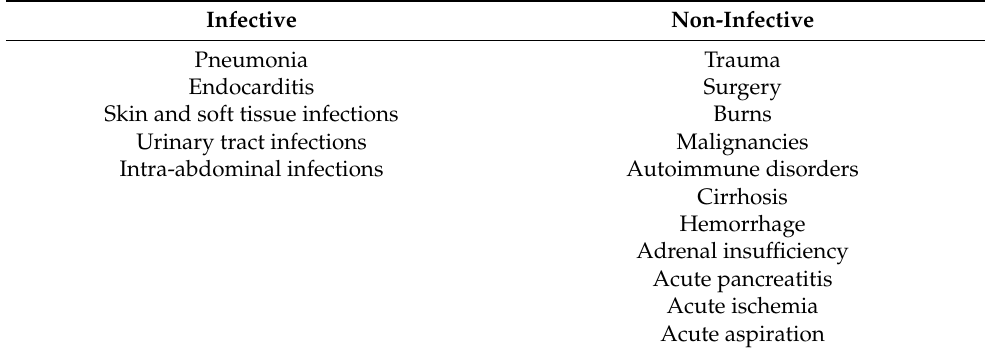
Table 1. Infectious and non-infectious causes of inflammatory host response. Infective Non-Infective Pneumonia Trauma Endocarditis Surgery Skin and soft tissue infections